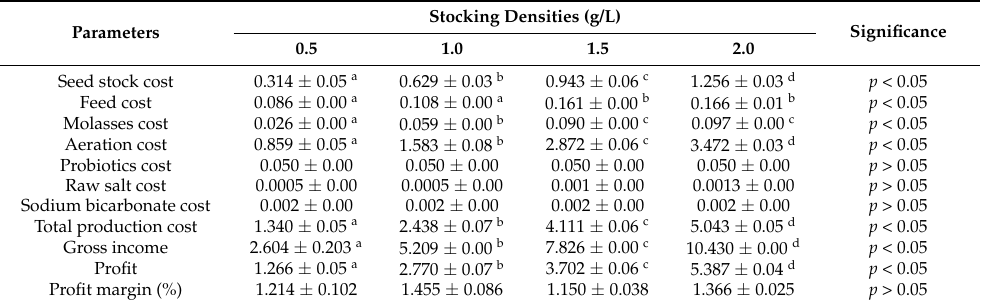
Table 4. Profitability analysis of O. bimaculatus seed reared in the biofloc system at different stocking densities having all harvested fish sold at the single selling price (USD 0.13 per piece).